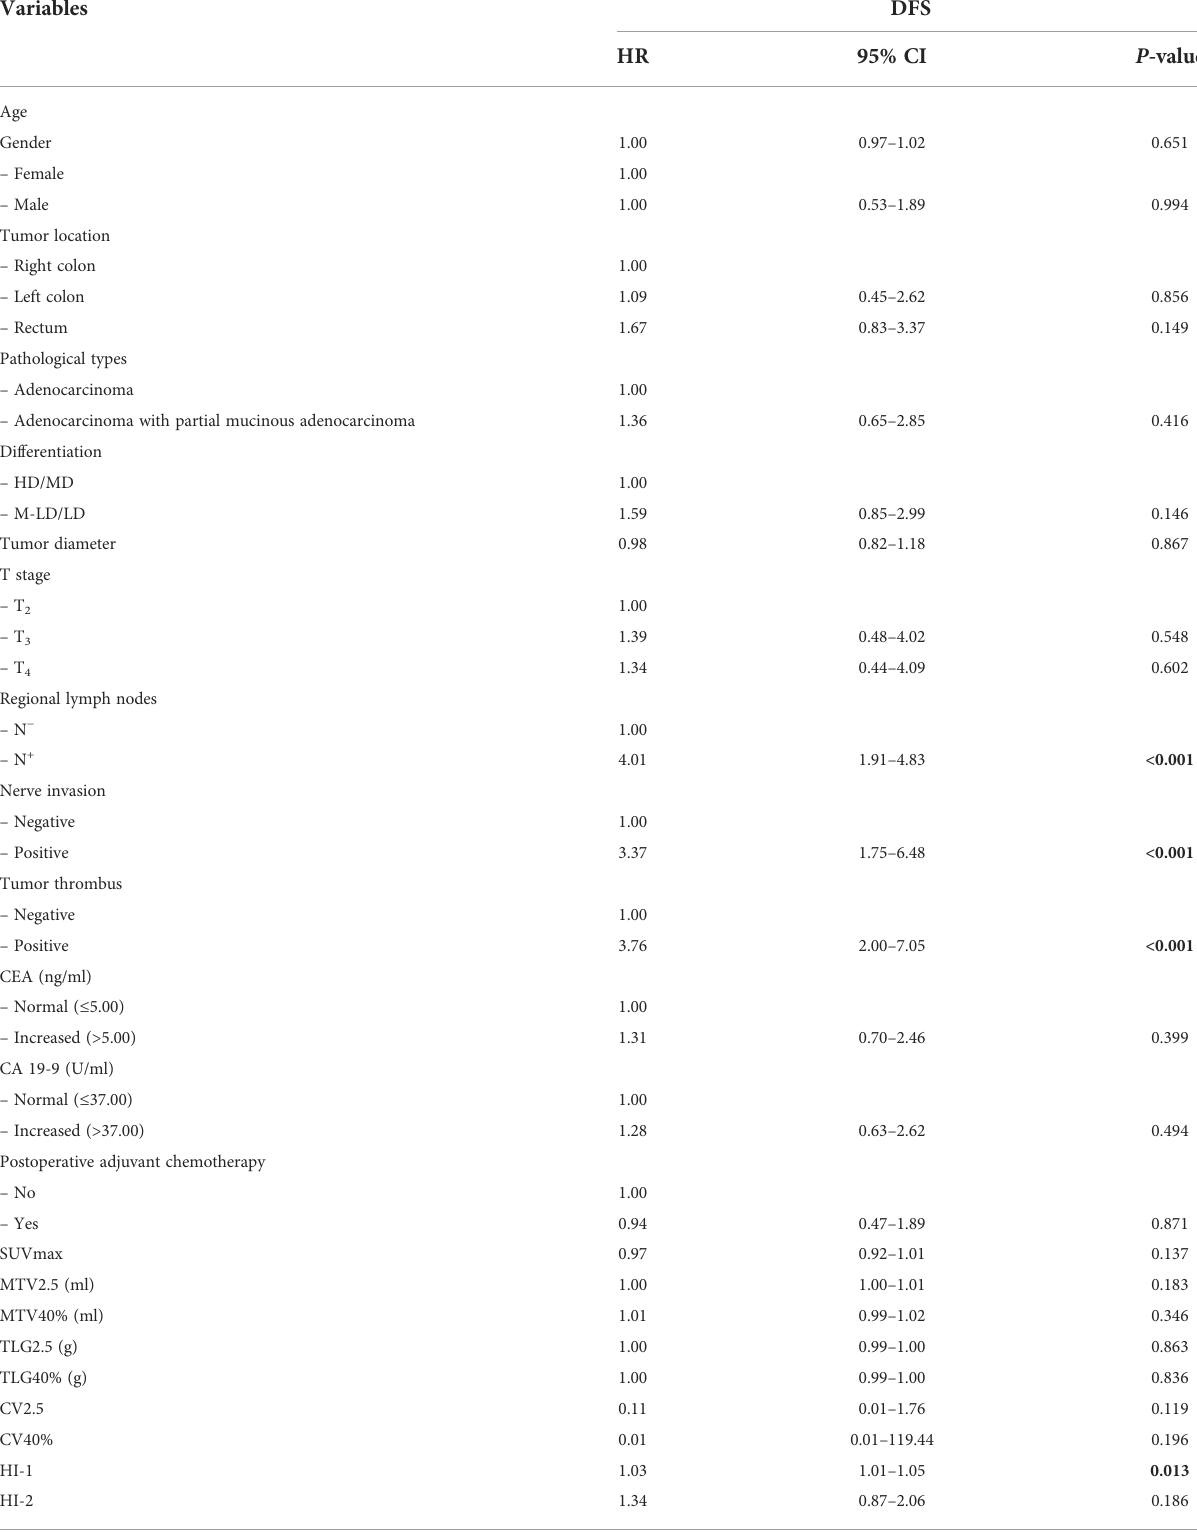
TABLE 5 Univariate Cox regression analyses for